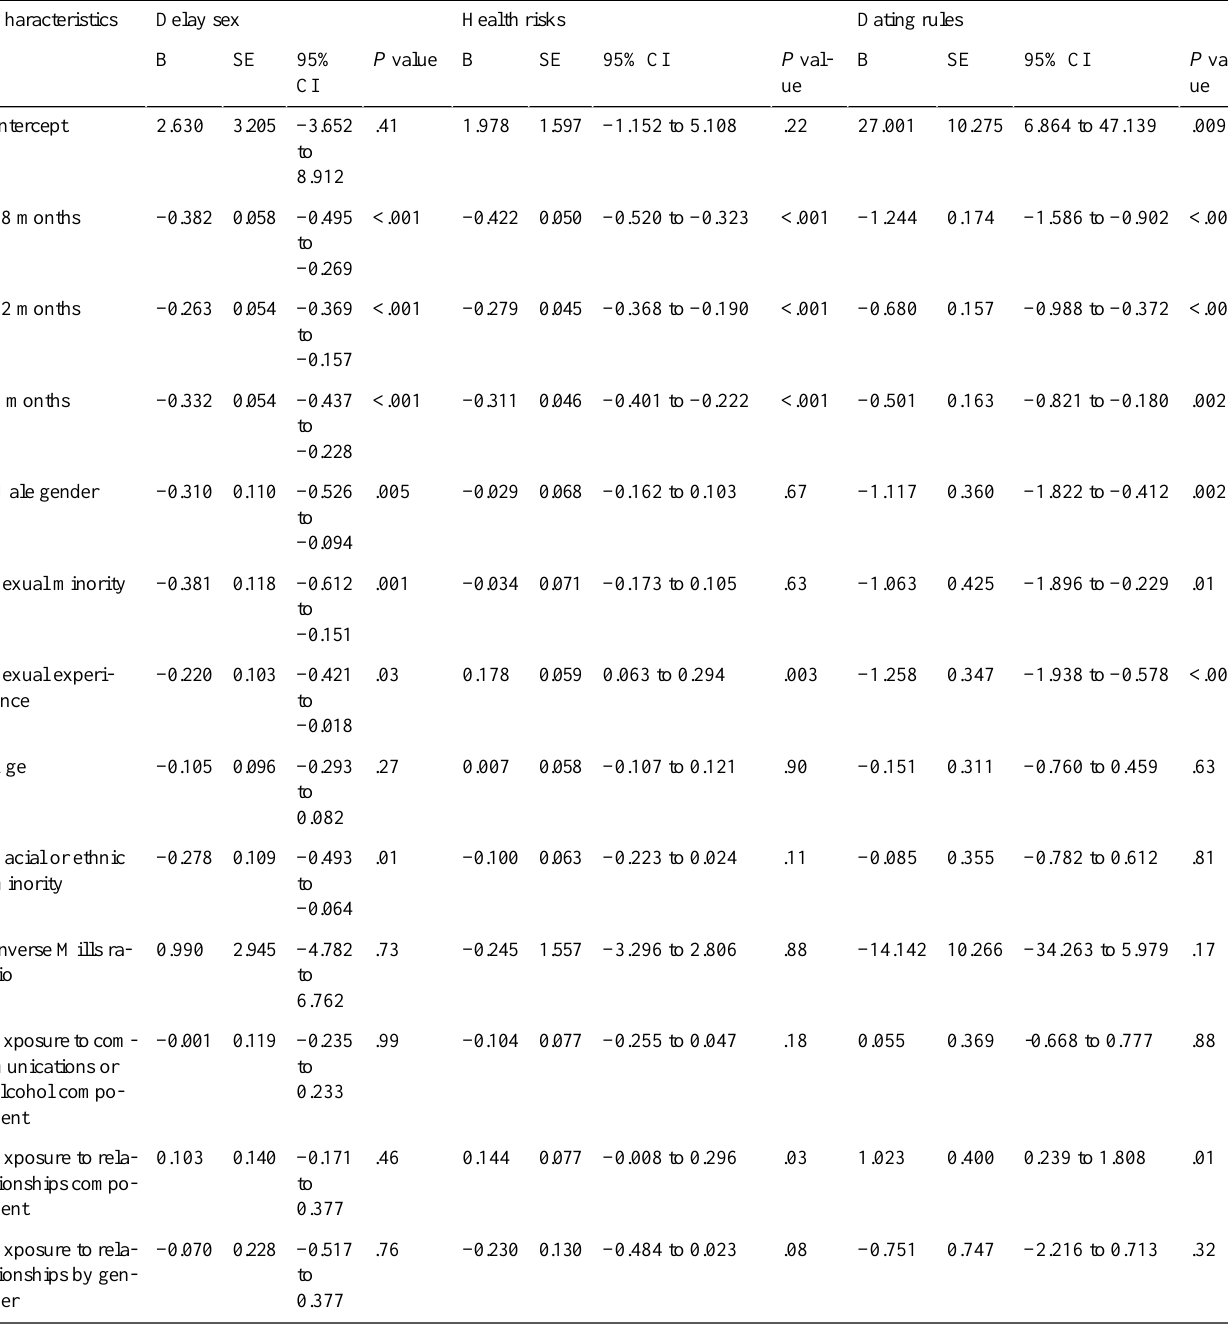
Table 6. Results from generalized estimating equations: interaction effects of intervention exposure on adolescent report of sexual communication by gender: cautionary communication (T0: n=411; T1: n=325; T2: n=311; T3: